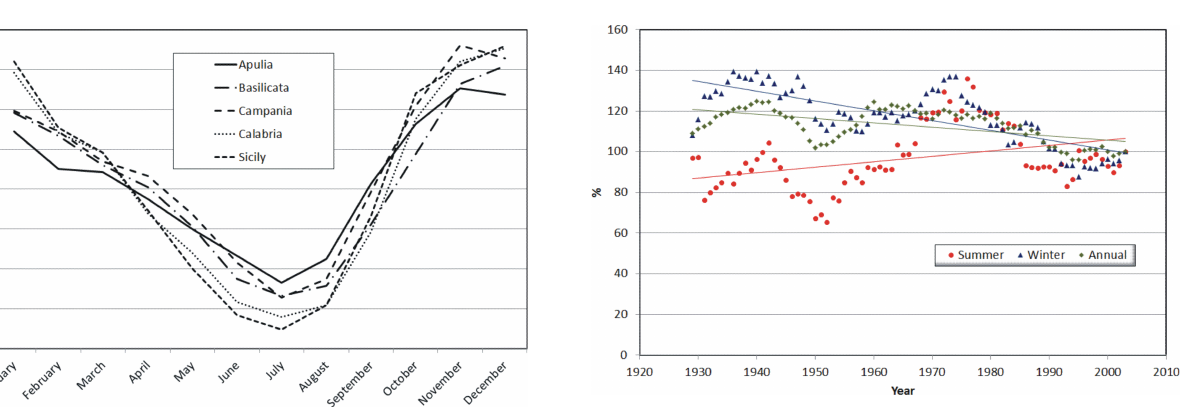
Fig. 2. Distributions of the ratios between the average monthly and annual rainfalls in the five regions of Southern Italy.